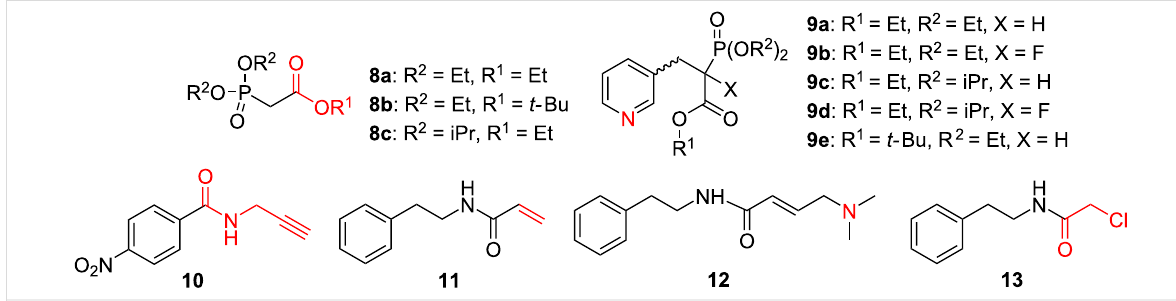
Figure 1: The model compounds used for this study (in red: the functionality of the molecules vulnerable to side reactions).